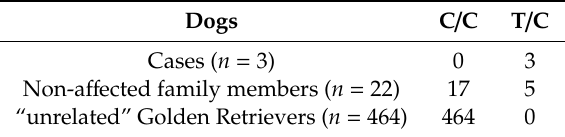
Figure 2. Details of the SIX6: c.487C > T variant. Representative electropherograms of two dogs with di ff erent genotypes are shown. The variable position is indicated by an arrow. Table 3. Genotype phenotype association of the SIX6: c.487C > T